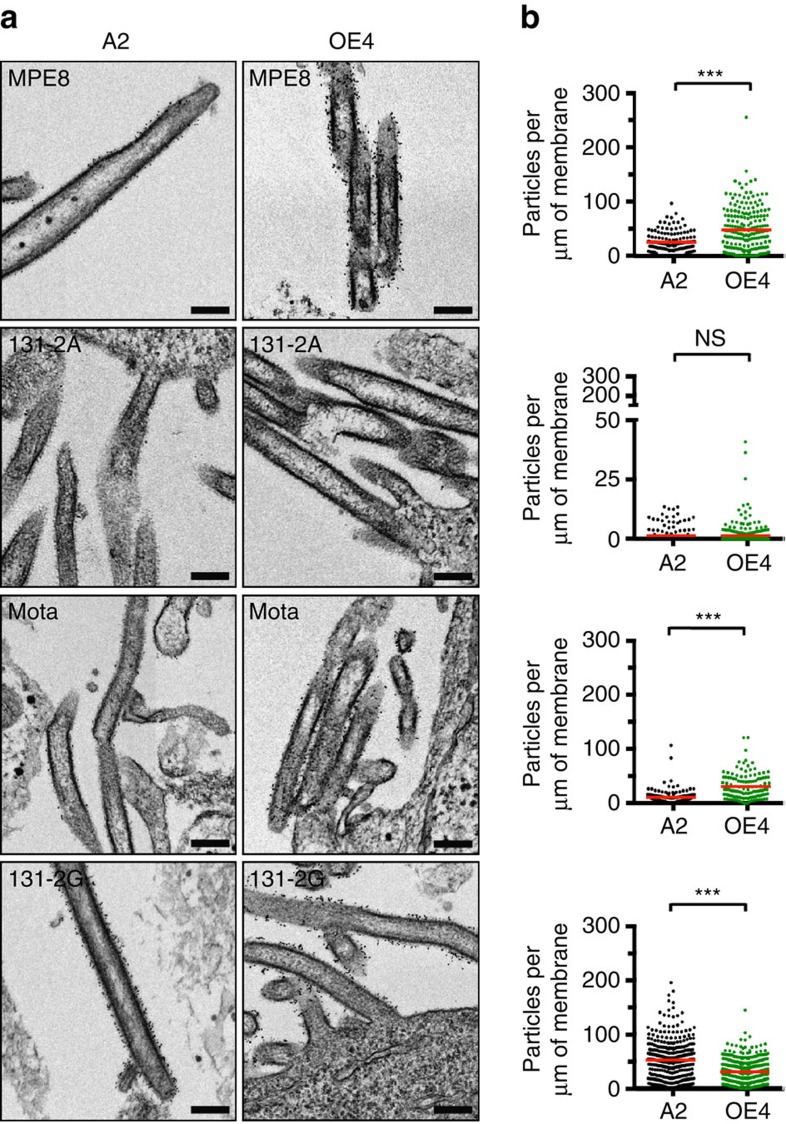
Immunogold labelling of RSV surface glycoproteins F and G.(a) Representative TEM images of BEAS-2B cells infected at an MOI of 10 with A2 (black) or OE4 (green) and labelled with MPE8 (pre-F mAb), 131-2A (post-F mAb), Motavizumab (total F mAb) or 131-2G (G mAb) and probed with gold-labelled secondary antibodies. (b) Quantification of the amount of immunogold particles per measured membrane length per virion. For each labeling condition, more than 100 virions (graph data points) were evaluated for each virus. The red lines represent the mean particle densities along the membrane for each condition. Significant differences are indicated by ***P<0.0005 determined by t-test with Welch's correction. Scale bars represent 200 nm.